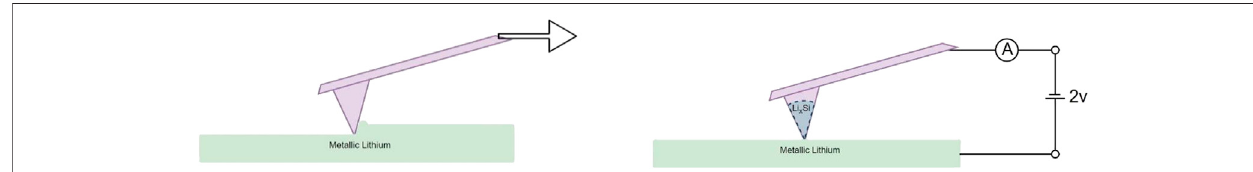
FIGURE 7 | Dry lithiation methods. Left: mechanical lithiation. Right: electrochemical alloying method.